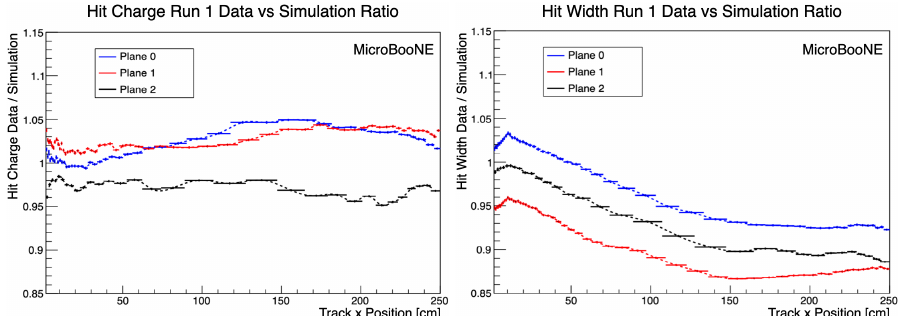
Figure 2. Plots of the ratios between data and simulation as a function of drift distance (X). The anode is approximately at x = 0. Images come from